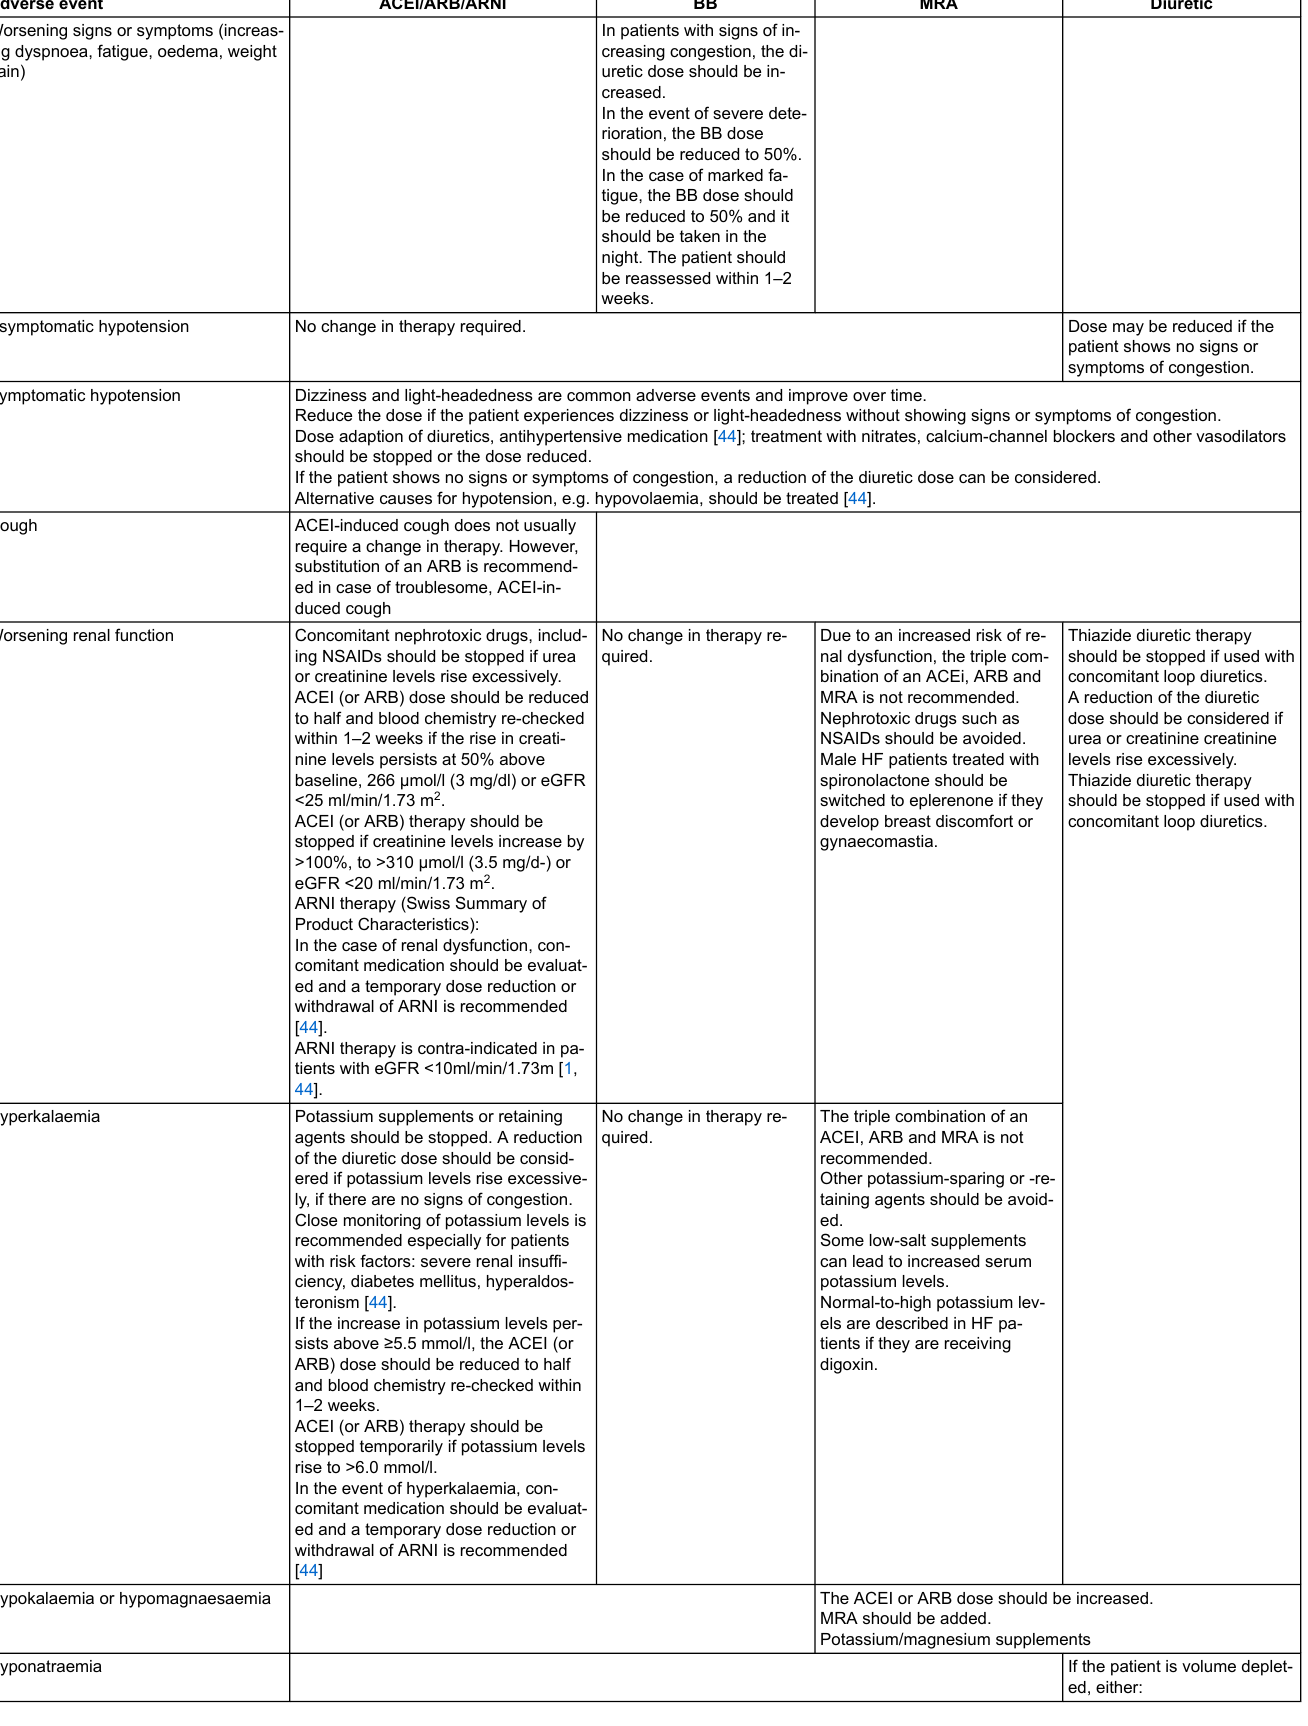
Table 3: Adjustment of HF medication in the case of adverse events. Adapted from Ponikowski et al. 2016 [1, 44]. Adverse event ACEI/ARB/ARNI BB MRA Diuretic Worsening signs or symptoms (increas- ing dyspnoea, fatigue, oedema, weight gain)